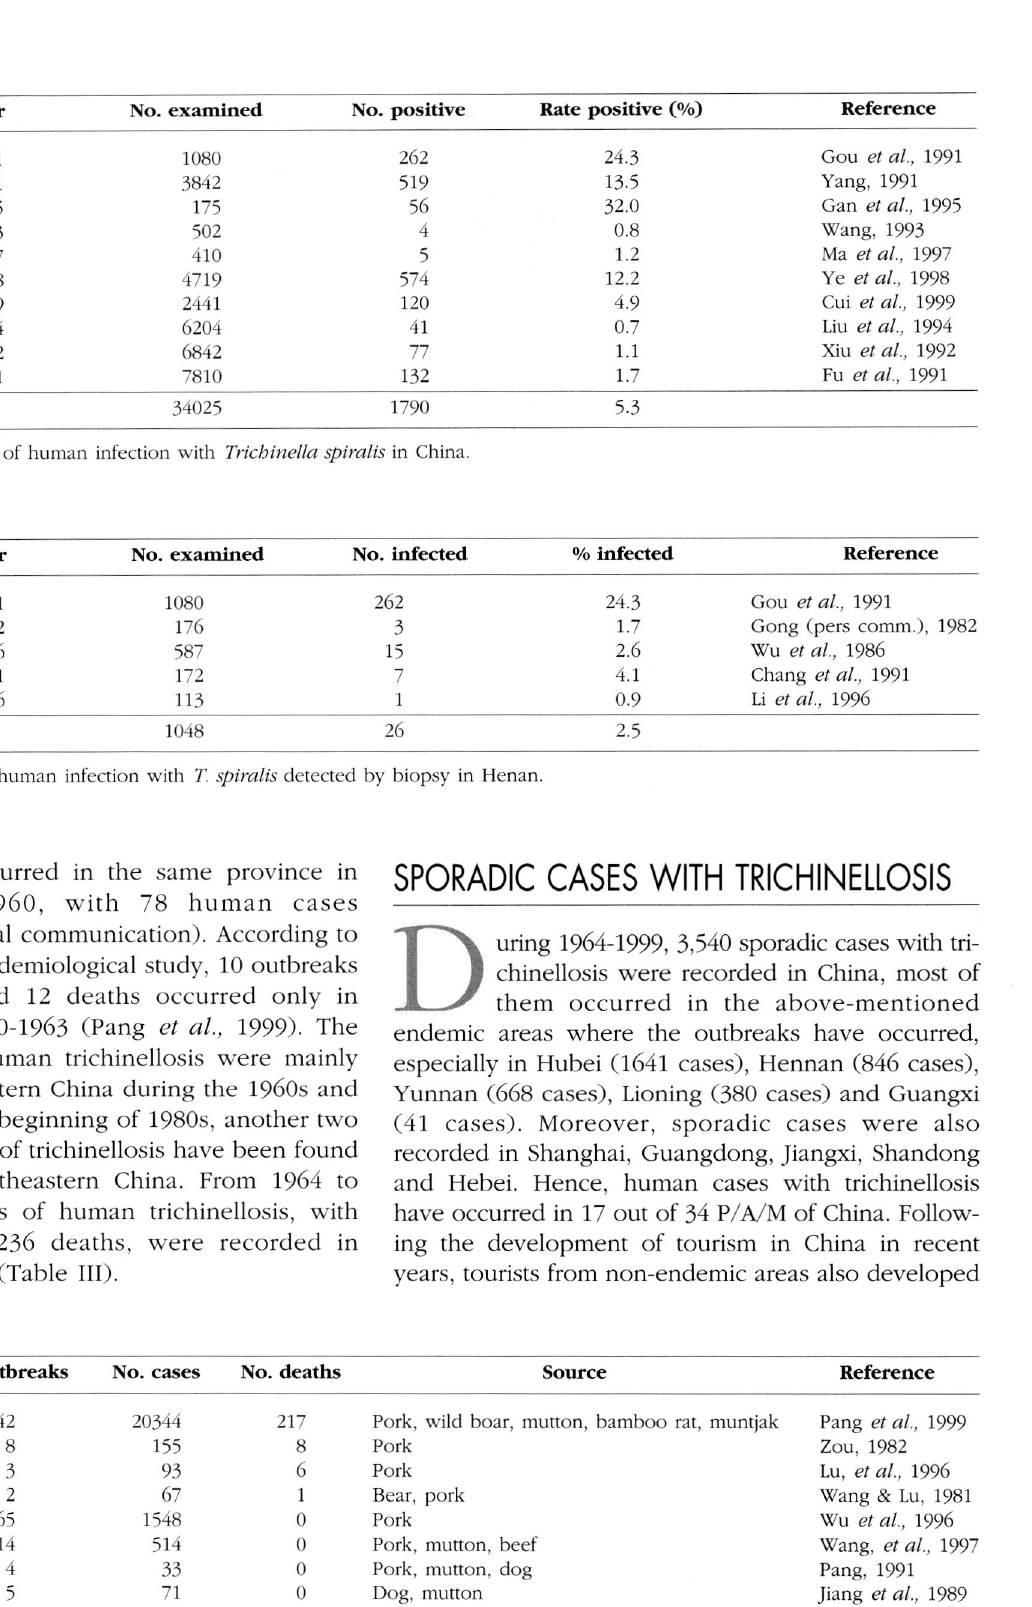
Table I. - Seroprevalence of human infection with Trichinella spiralis in China.